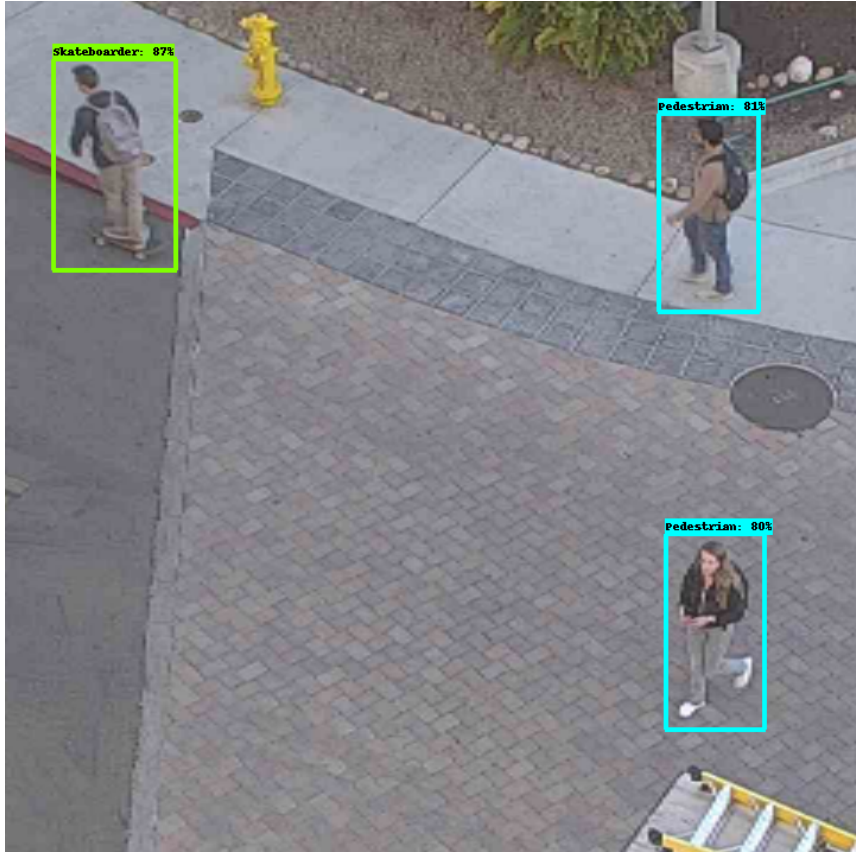
Figure 20. The SSDV1lite model predicts the skateboarders with the confidence of 87% and the two pedestrians with the confidence of 81% and 80%.